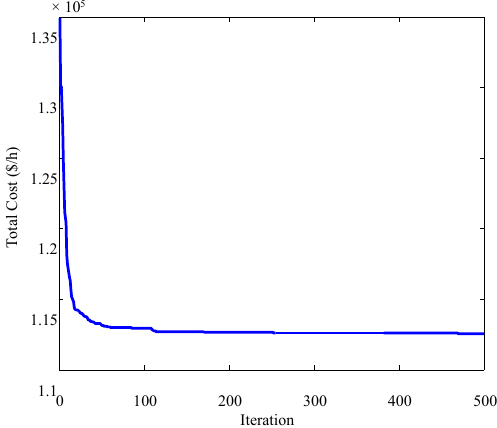
Figure 5. Total cost convergence curve for case 12.